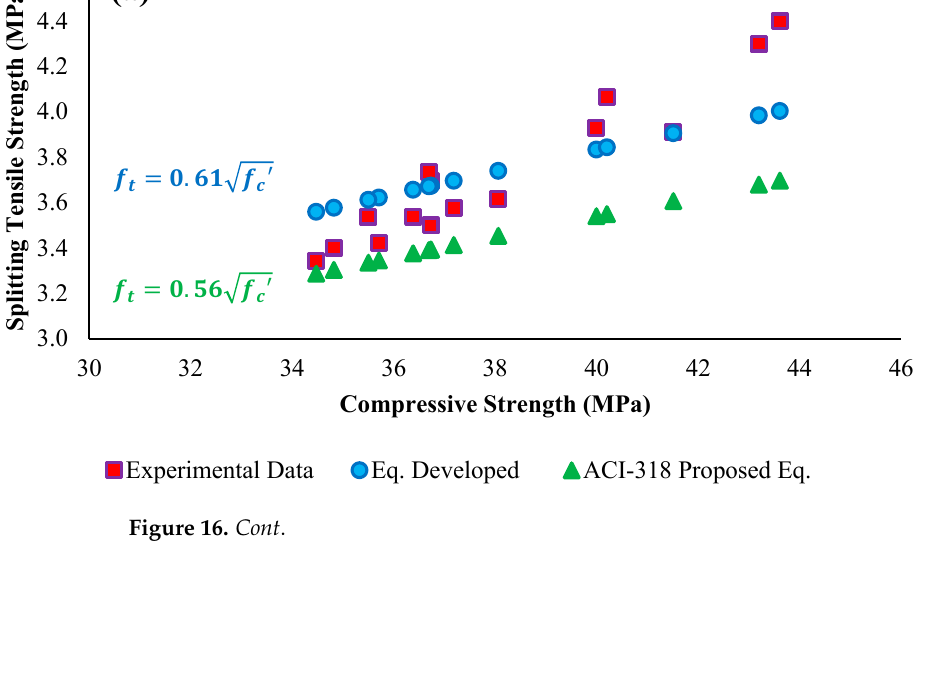
Compressive Strength (MPa) Experimental Data Eq. Developed ACI-318 Proposed Eq. Figure 16. Cont